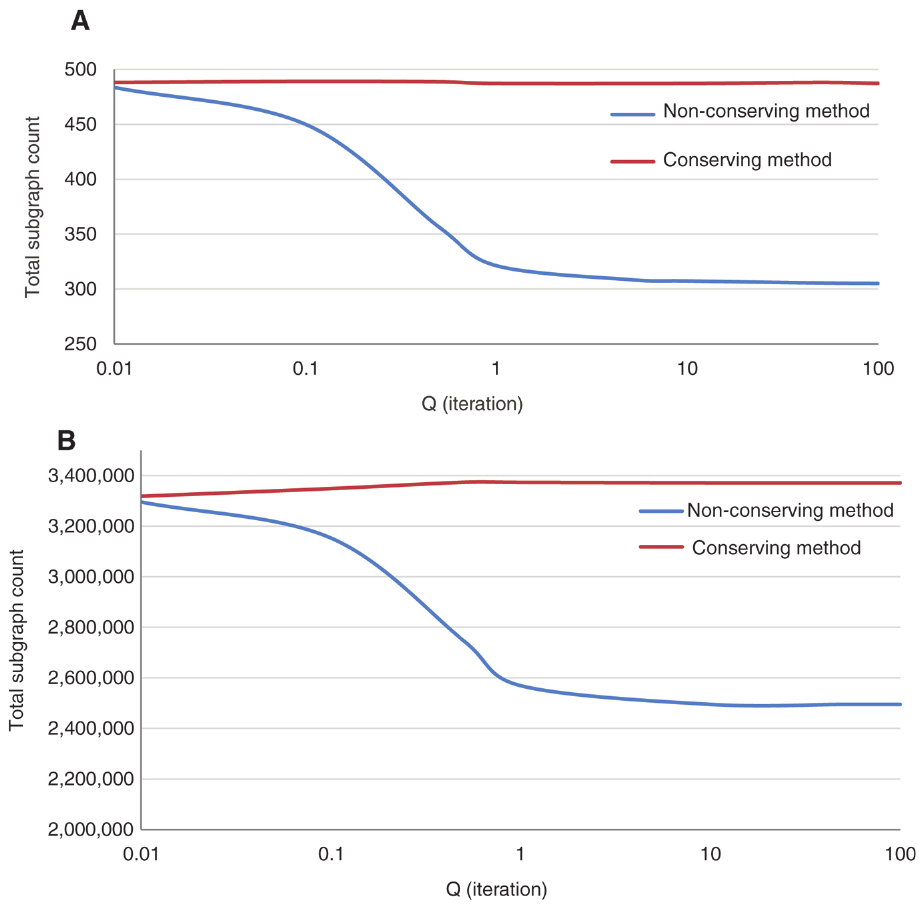
Figure 4: Total number of subgraphs vs. number of iterations for (A) the BC-complete and (B) the GBM